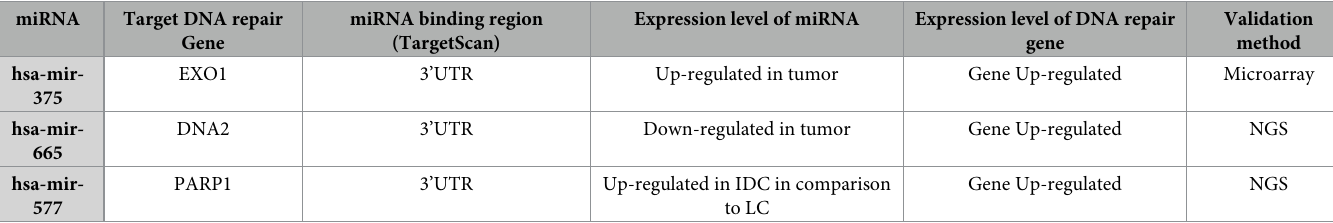
Table 1. Selected DEMs that target DNA repair